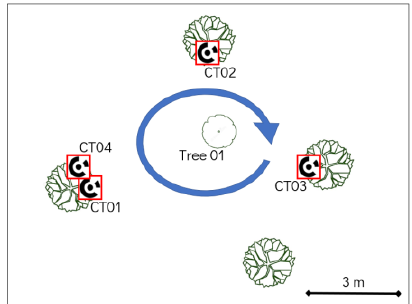
Figure 2. Situational top-down sketch of the dataset used in this paper with distribution of CT. The blue arrow indicates the direction of data